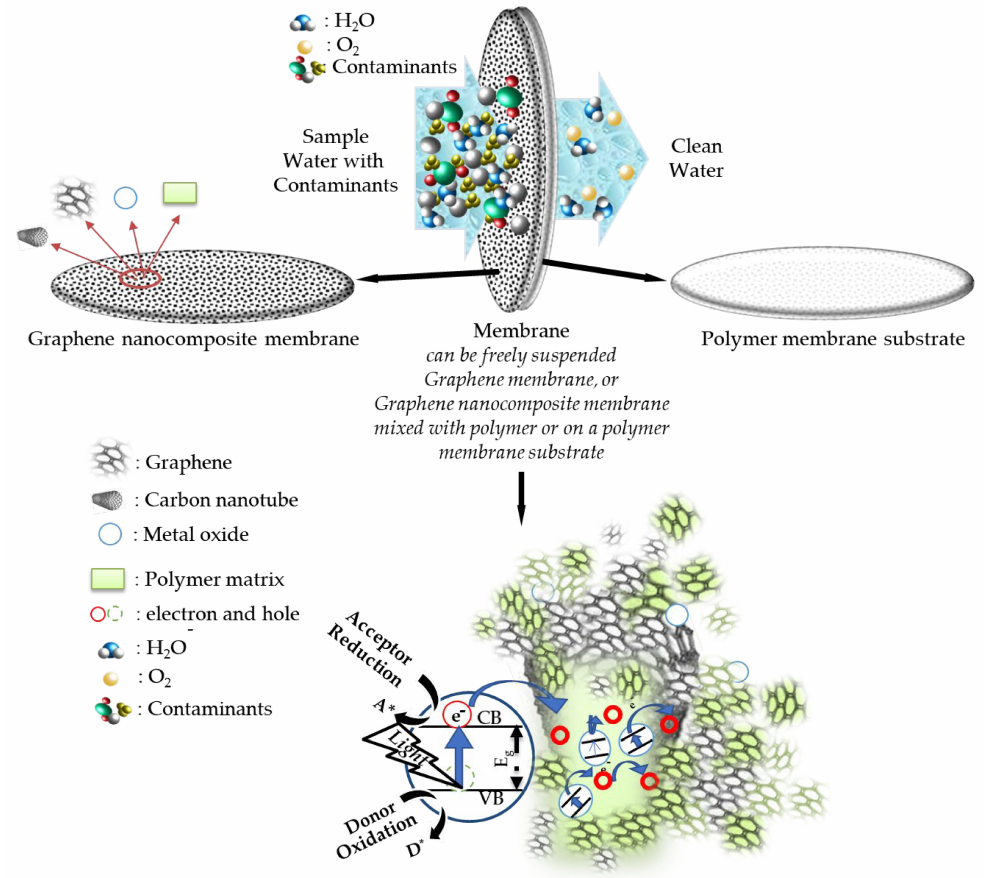
Figure 10. Schematic examples of a membrane structure, water permeation process, and a photocatal- ysis